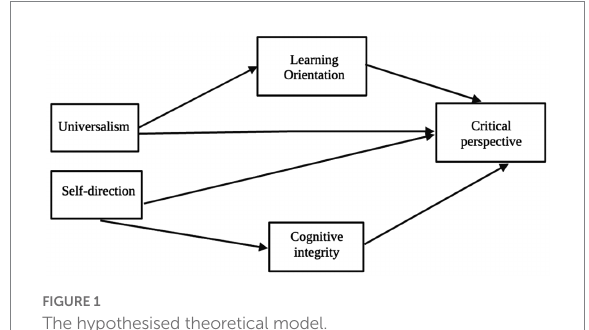
FIGURE 1 The hypothesised theoretical